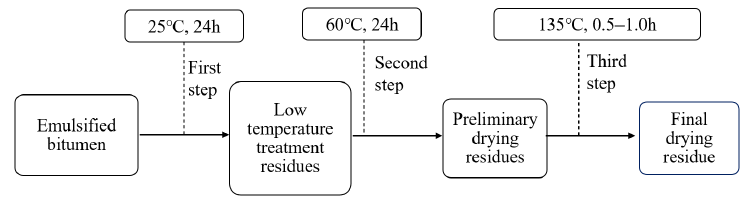
Figure 3. Flow chart of low temperature evaporation